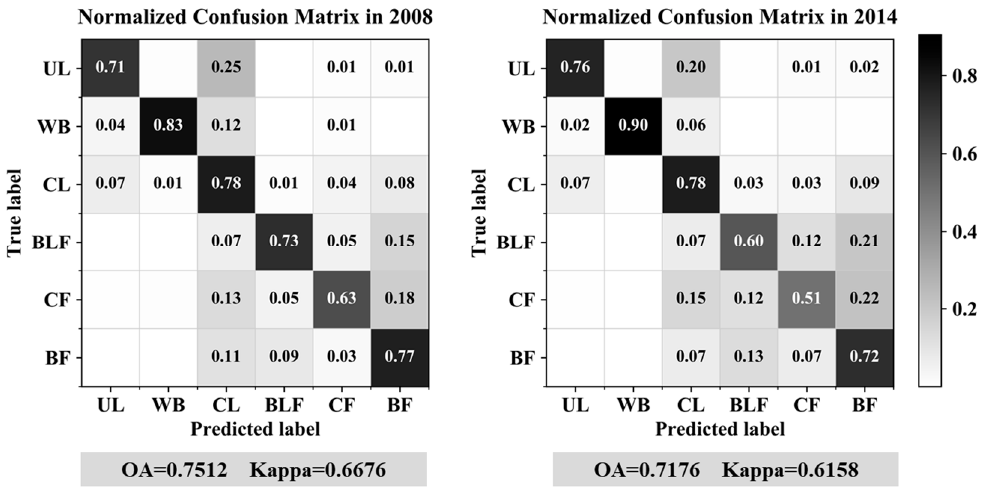
Figure 10. Normalized confusion matrices between predicted results and true label in 2008 and 2014.